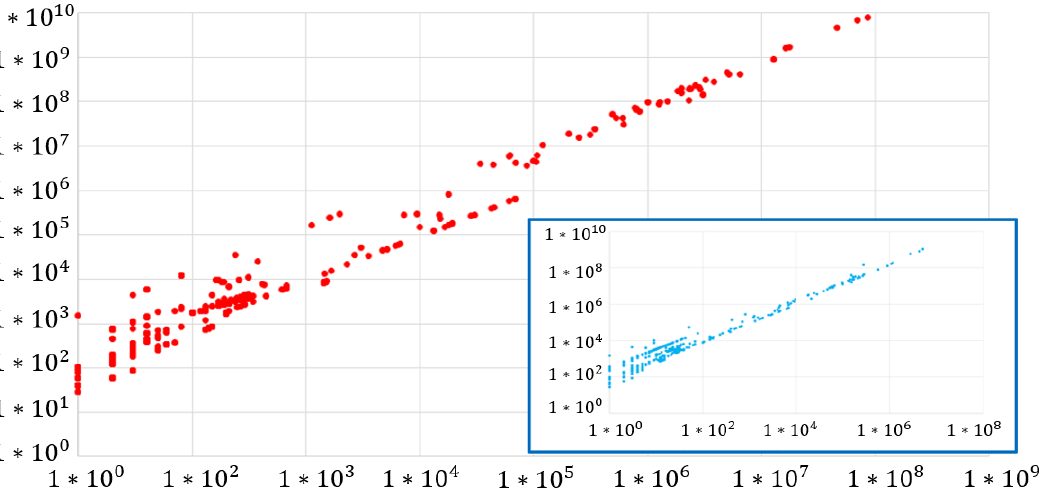
Figure 9. Downlink (red) and uplink (blue) traffic flow distribution of APN "B" (x axis: number of packets, y axis: Size of flows [Byte]).